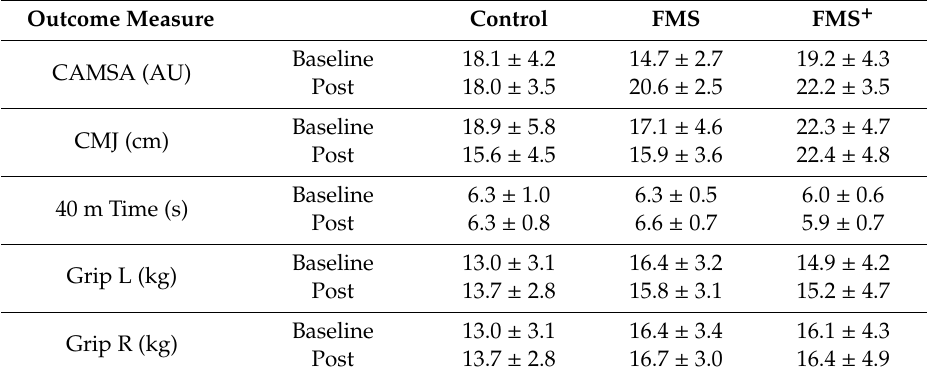
Table 4. Baseline and post-intervention mean and standard deviation for each group.